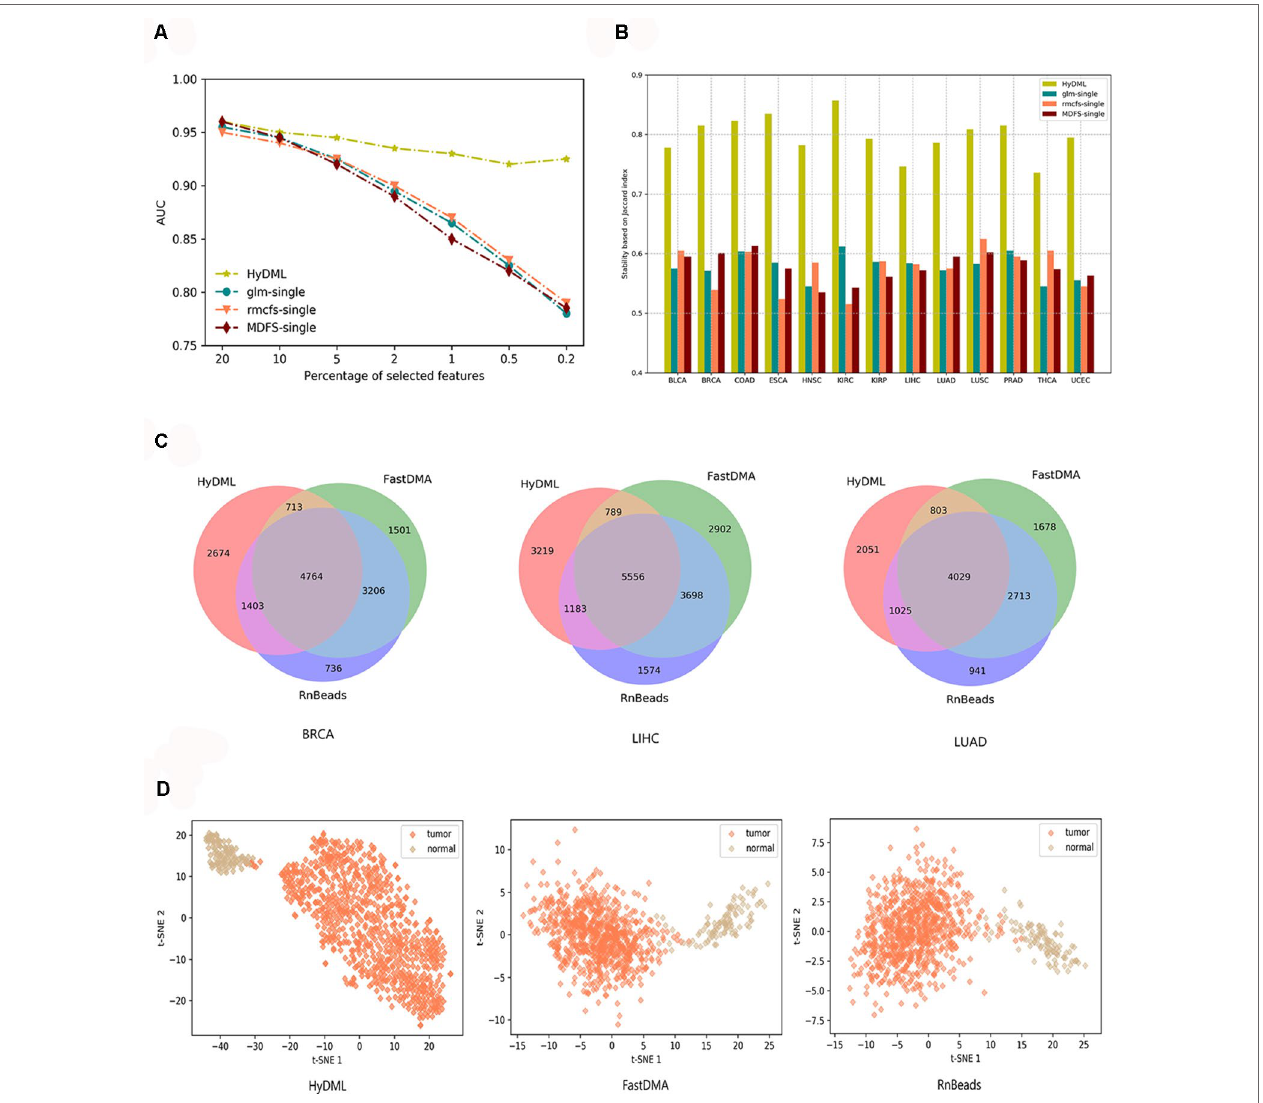
FIGURE 3 | Thorough classification performance and the robustness measure to compare different models in identifying differential methylation sites. (A) Classification performance of HyDML and its corresponding submethods as the selected features (loci) gradually reduce in PRAD. (B) Comparison of robustness measure using Jaccard index in 13 cancers for HyDML and its corresponding submethods. (C) Relationship of differential methylation sites obtained by HyDML/ FastDMA/RnBeads in BRCA; LIHC and LUAD (corresponding to the three independent test sets) using a Venn picture. (D) T-SNE clustering results in BRCA using the unique differential methylation sites selected by each